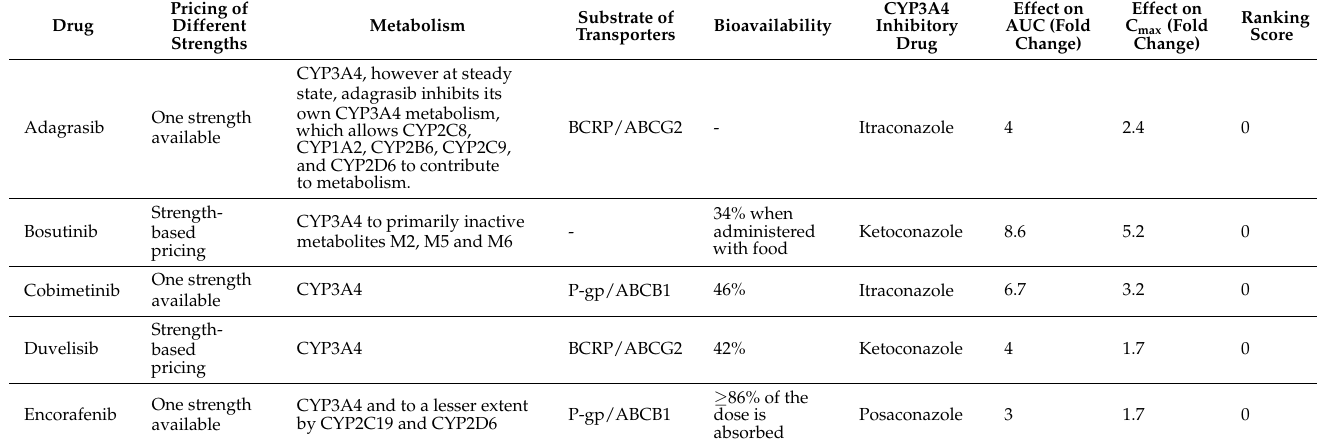
Table 3. Selection of potential CYP3A4 boosting candidates ( n = 78). Drugs are ranked according to ranking score (low → high) and on alphabet within the same ranking score. Candidates with the lowest ranking score have the most potential for CYP3A4 boosting. Relevant drug characteristics were retrieved from the Summary of Product Characteristics (SmPC), European Public Assessment Reports (EPAR) and UpToDate